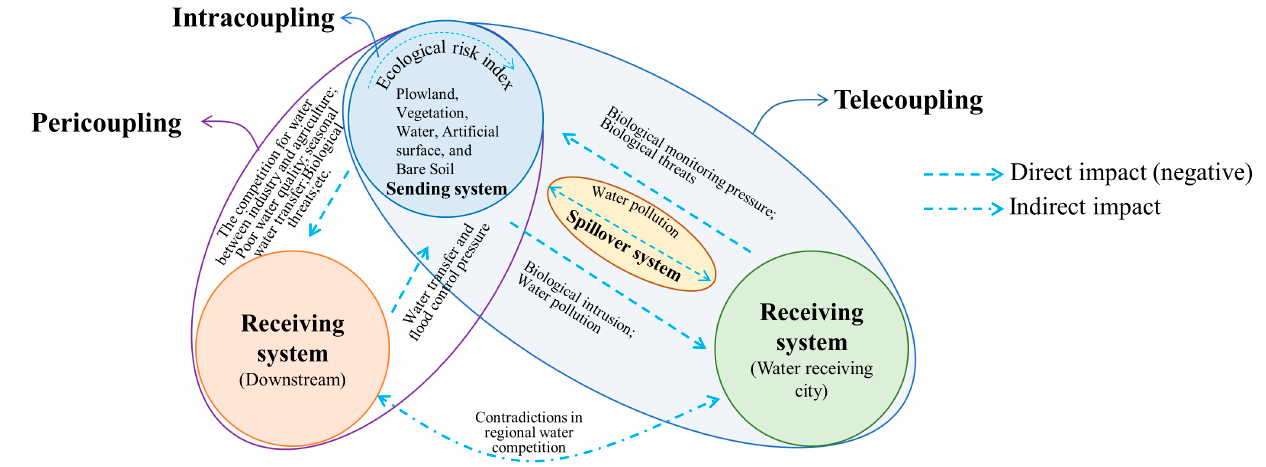
Figure 8. Ecological risk of the metacoupling of SNWTP ‐ MR.